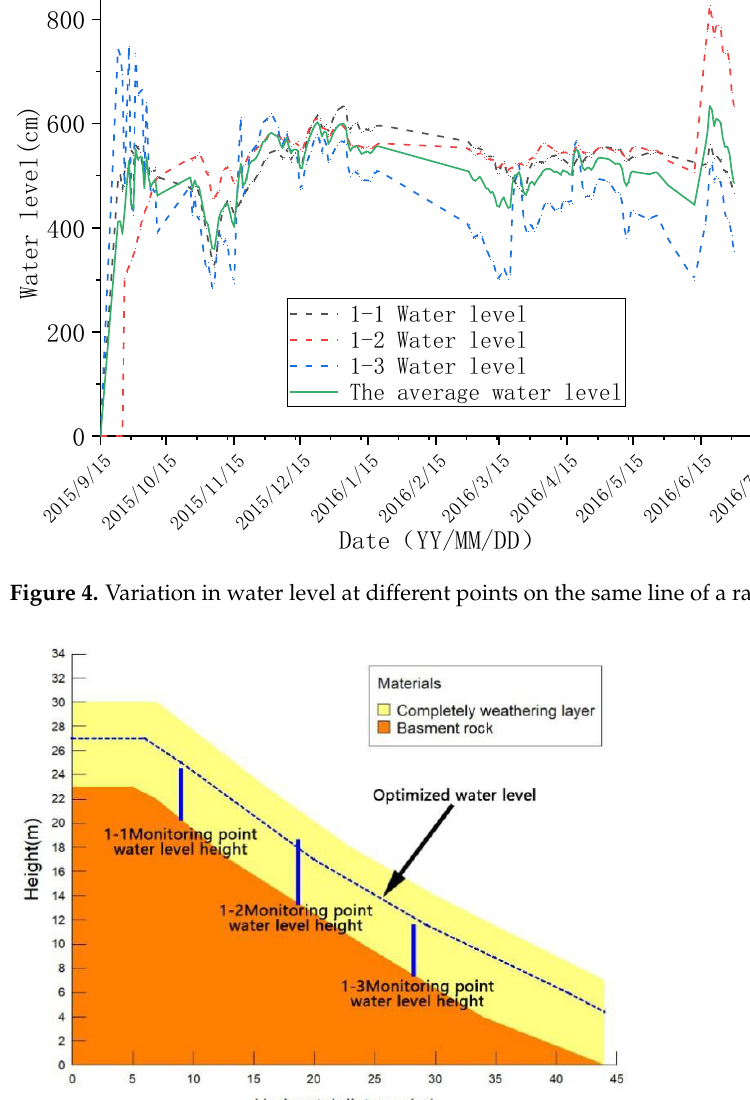
Figure 5. Schematic diagram of water level optimization.